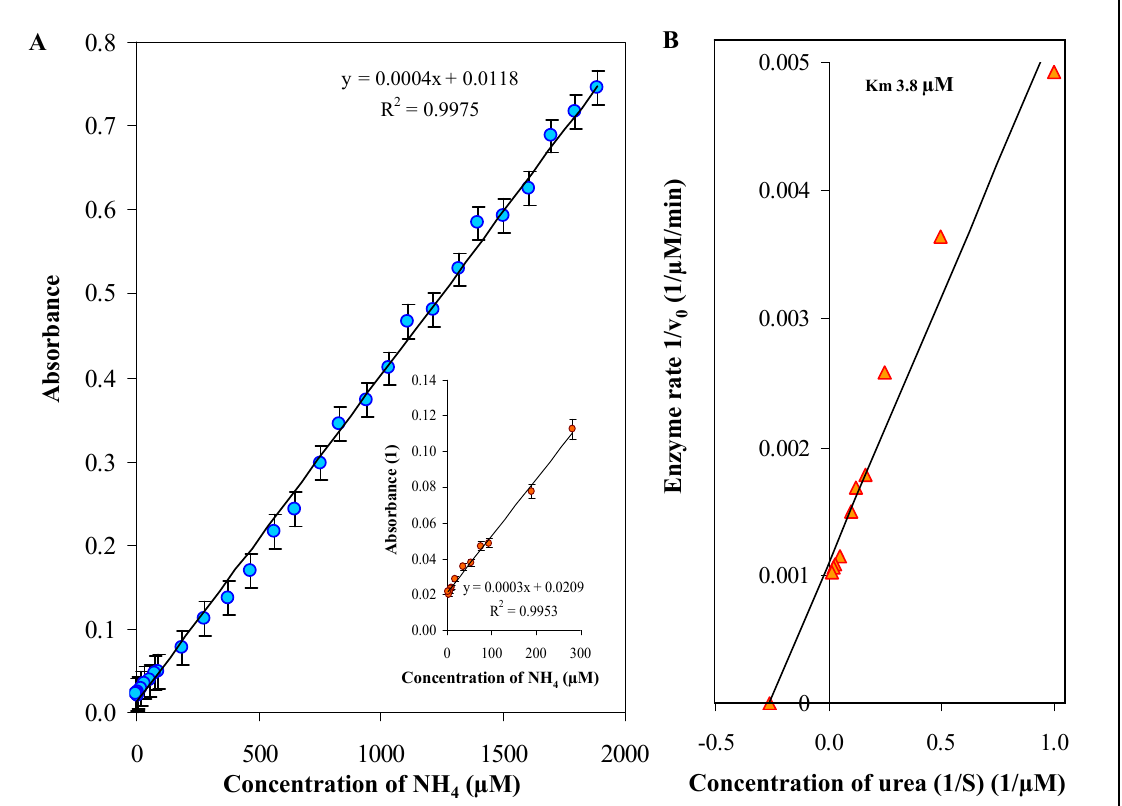
Figure 10. Spectrometric automated analysis of urease activity. The dependence of total amount of released ammonia on height of the obtained signal ( A ). Enzyme kinetic of soybean urease ( B